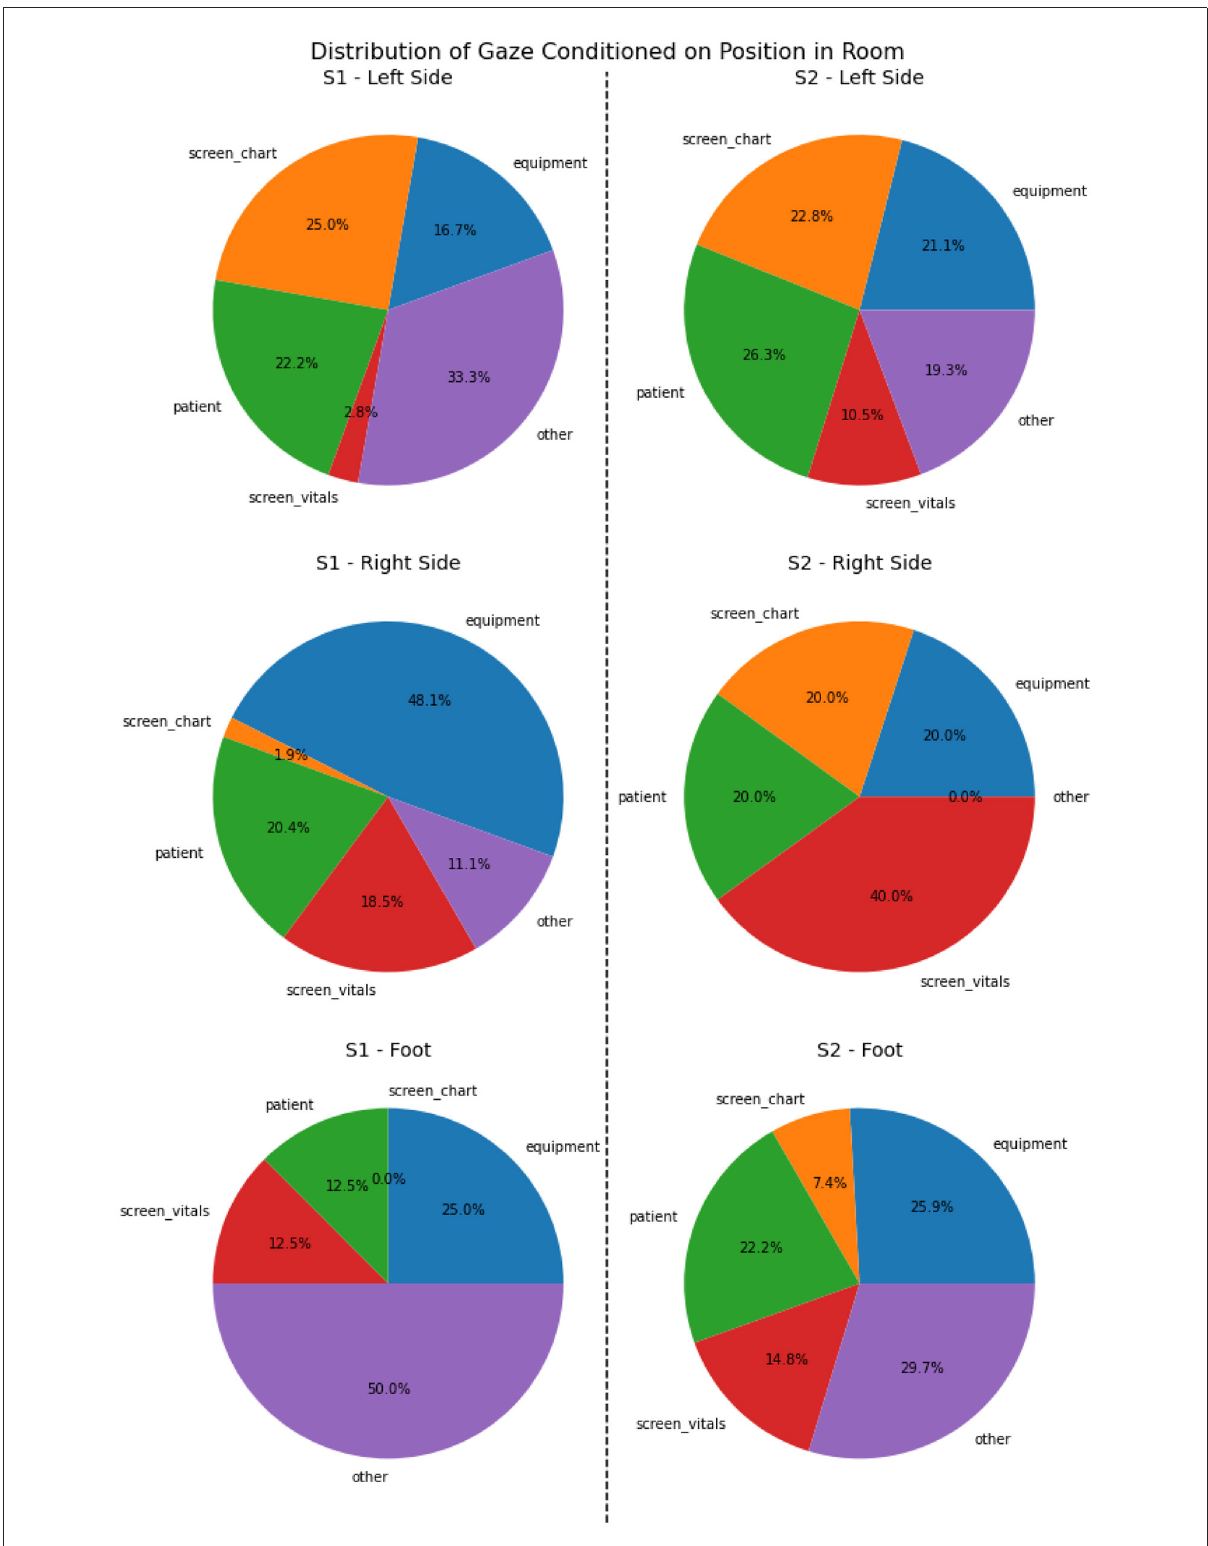
FIGURE11 Distribution of gaze across five major object categories conditioned on the nurse’s position in the room for each scenario.